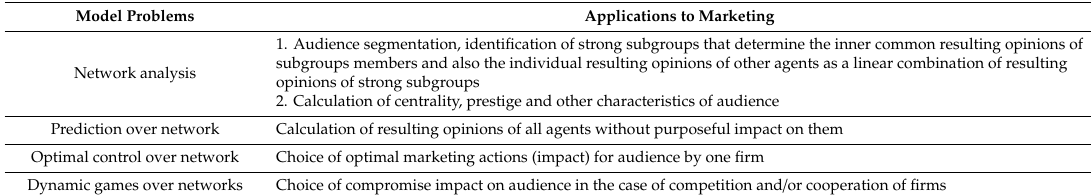
Table 4. Models of influence and control over networks and their applications to